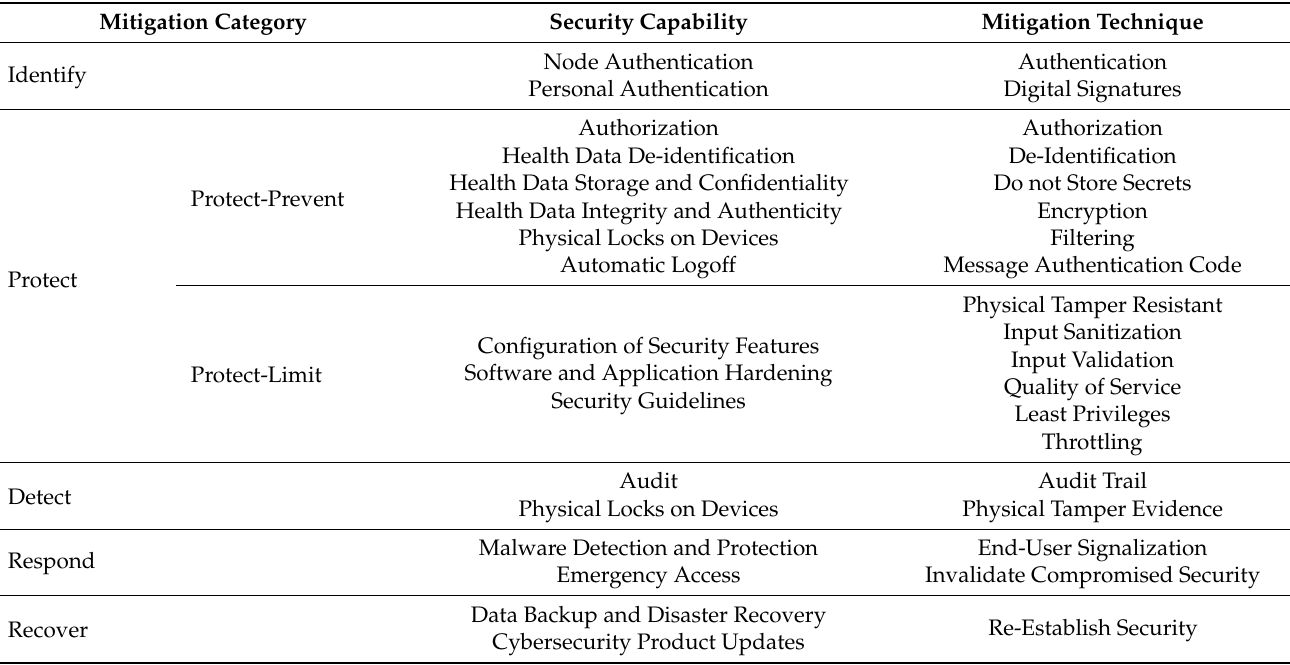
Table 2. Mitigation categories, security capabilities, and mitigation